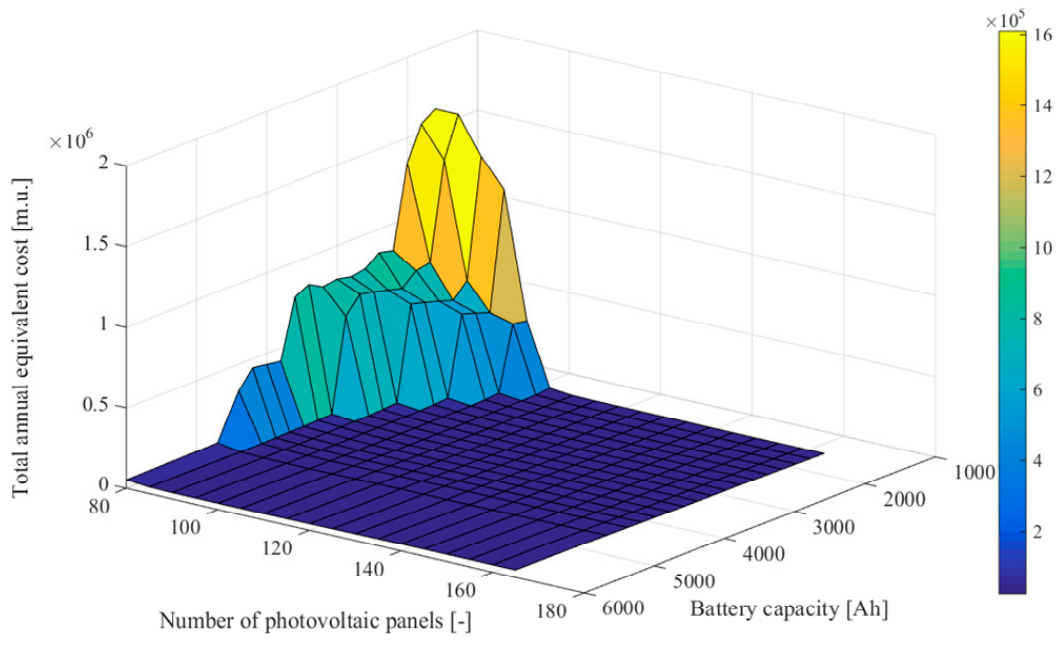
capacity of the 108 V AGM VRLA battery system while the PVs population is 120. Figure 16. Equivalent annual total cost with respect to the interest rate without inflation and to the